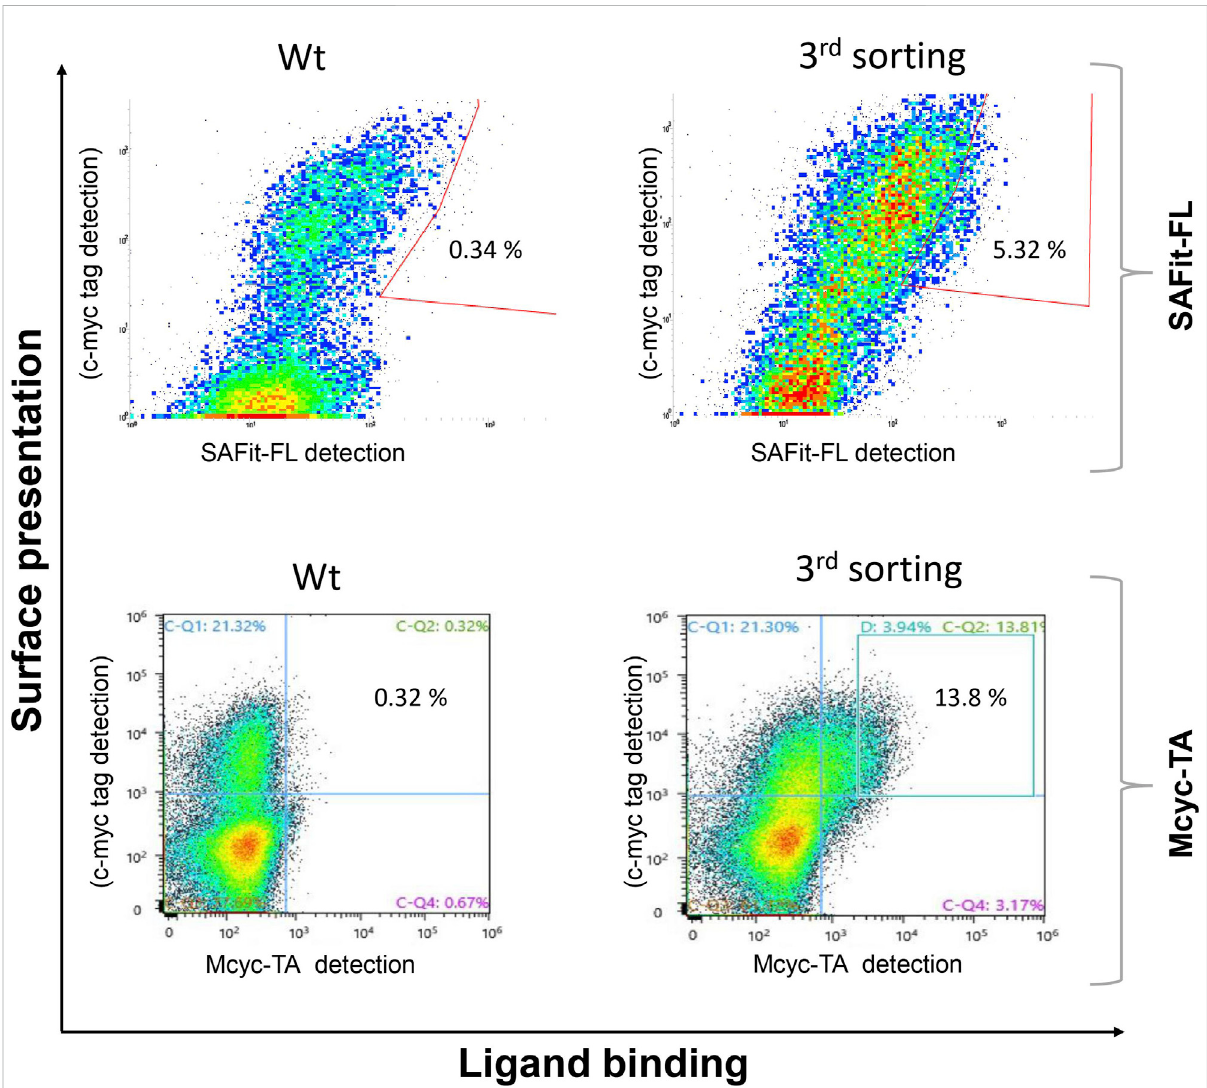
FIGURE 4 SitesaturationmutagenesisYSDlibraryscreeningandsorting.Cellsshowingbothsurfacepresentation(c-myctagdetection)andligandbinding signal (SAFit-FL (out/in) or Mcyc-TA (out/out) ) were sorted to enrich the population of ligand binder variants after site saturation mutagenesis for positions 63 to 70 of the FKBP51 sequence. Sorting gate was set to capture approximately 1% of the tracer binding population and used for subsequent sorting rounds or single clone